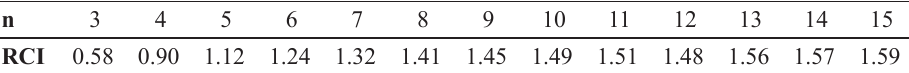
Table 4. The Random Consistency Index (Saaty 1980)